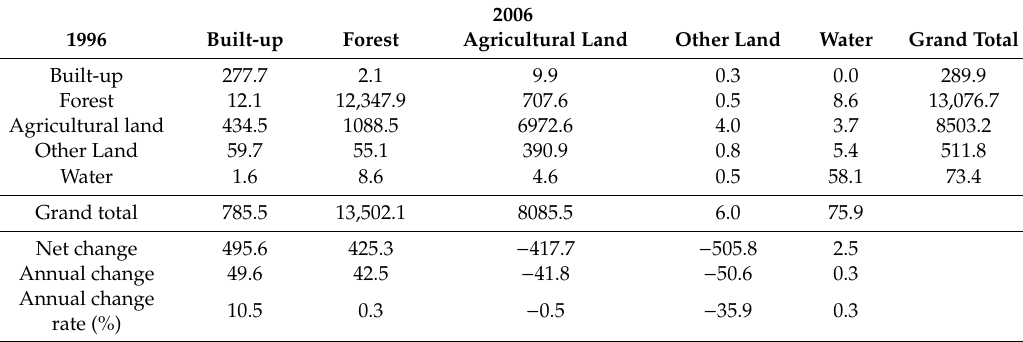
Table 6. Land use and land cover change matrix (ha), 1996–2006.